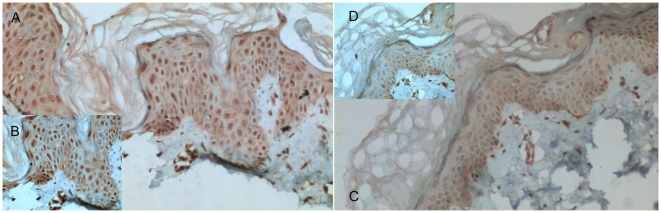
Immunohistochemical staining of XBP1 protein in the paired lesional (A,B) and non-lesional skin (C,D) of a patient with vitiligo (magnifications: (A,C)×200; (B,D)×400).